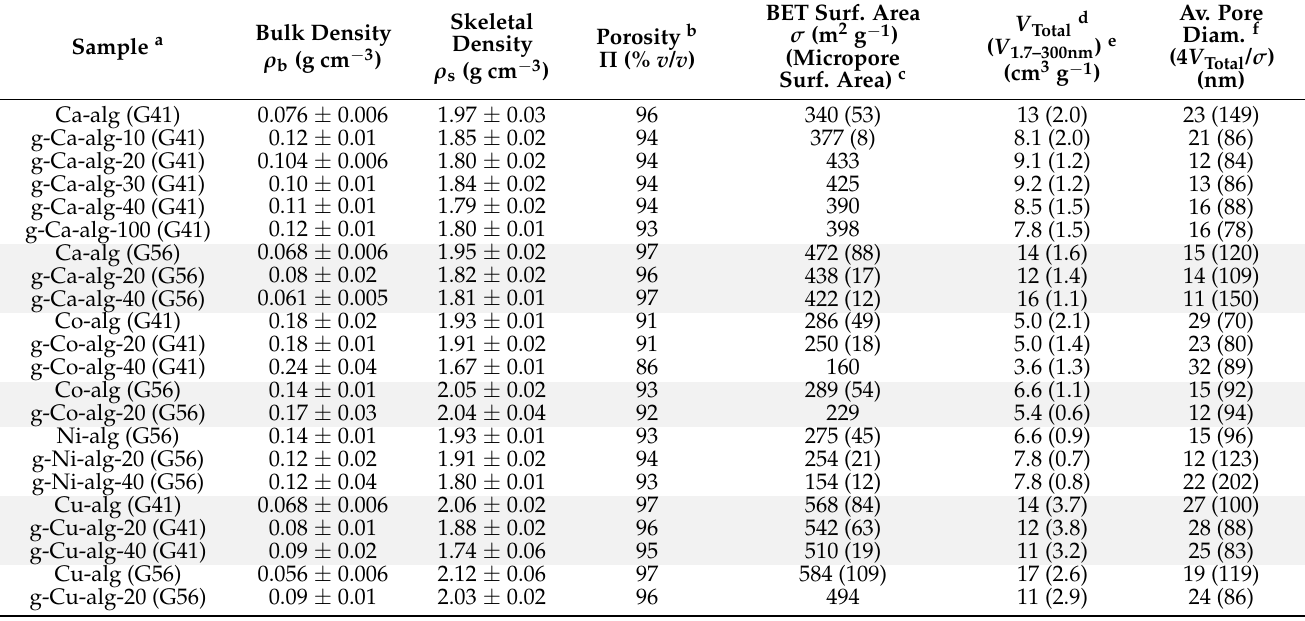
Table 2. Selected material properties of M-alginate and g-M-alginate aerogel beads.